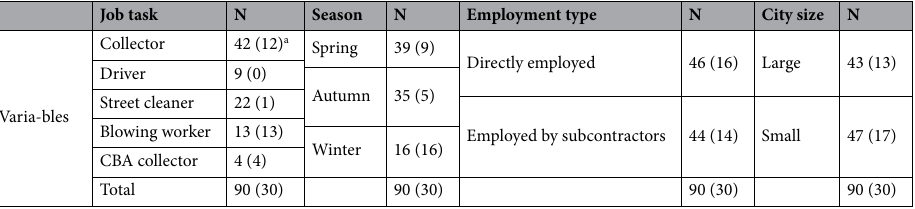
Table 2. TD, RD and RCS sample size by different variables. TD total dust, RD respirable dust, RCS respirable crystalline silica. a Number of TD samples.